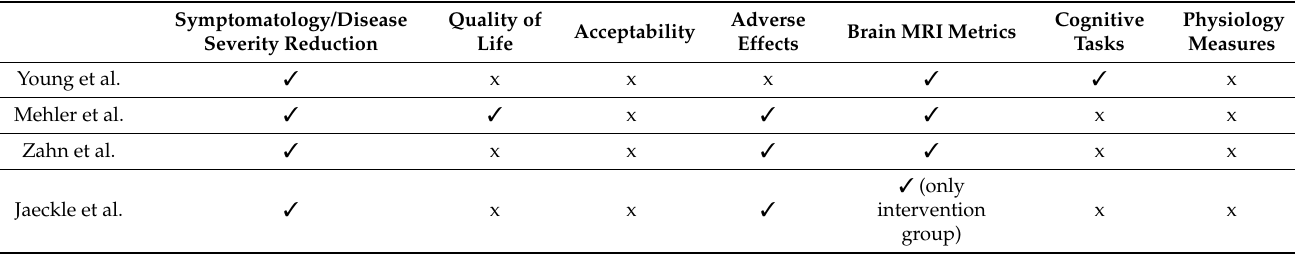
Table 3. Summary of reported